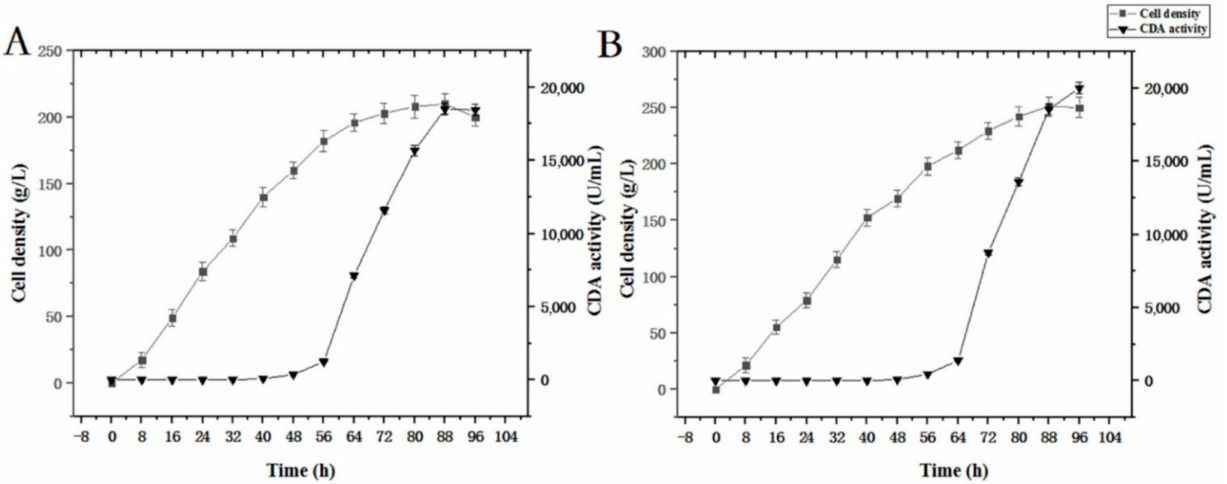
Figure 5. Time course of free CDA fermentation. ( A ) Induction was initiated when OD 600 = 150; ( B ) induction was initiated when OD 600 = 200.